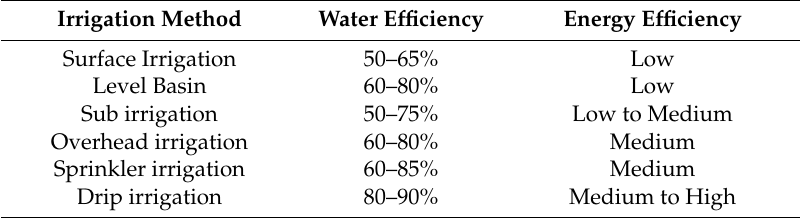
Table 1. Comparison of efficiency in various irrigation methods [2].